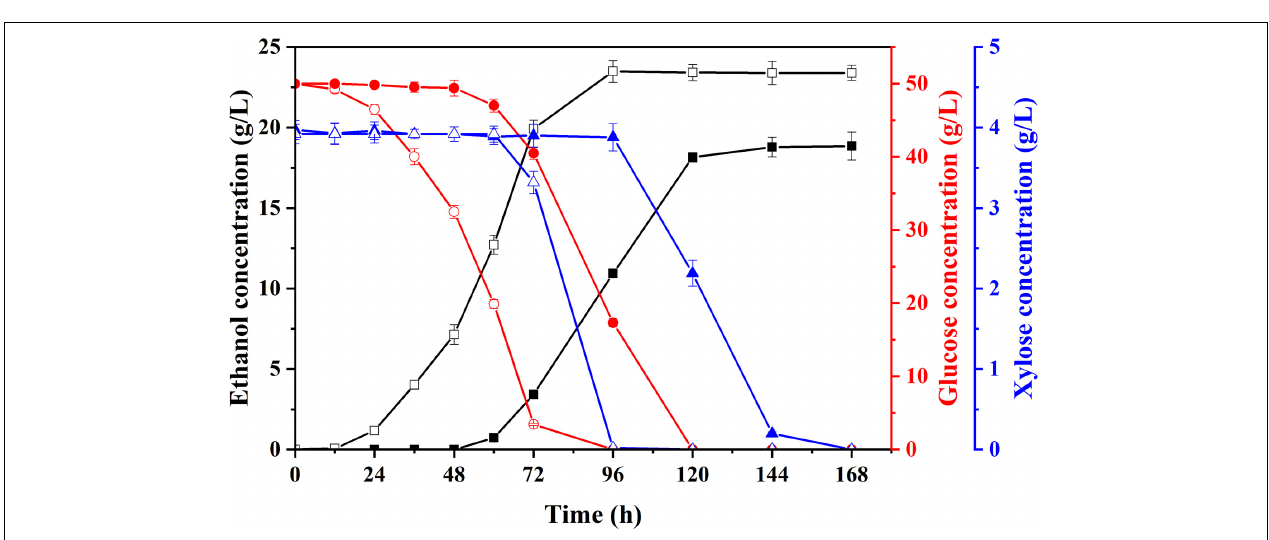
FIGURE 3 | Changes in concentrations of ethanol, glucose, and xylose of parent strain (solid) and domesticated yeast (hollow) in acclimation medium with the highest inhibitors concentration supplemented with glucose. Ethanol, square; glucose, circle; xylose,